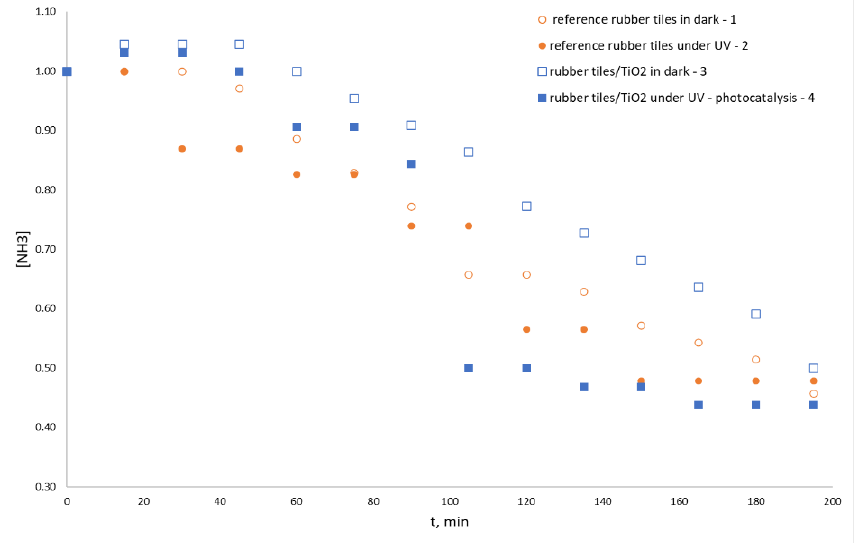
Figure 15. Measured concentration of NH 3 at the outlet of the PWT reactor during experiments.